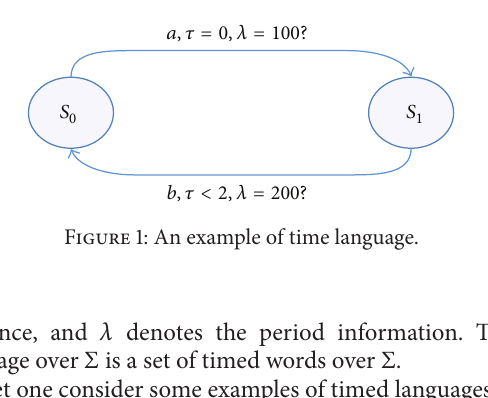
sequence, and 𝜆 denotes the period information. Timed language over Σ is a set of timed words over Σ